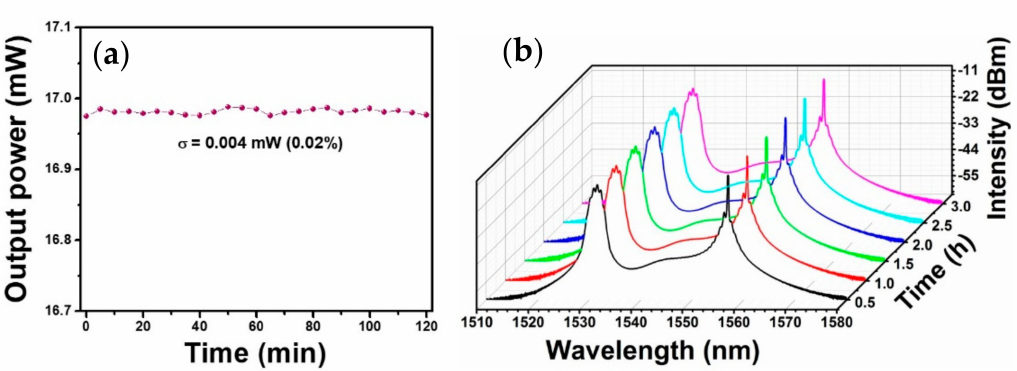
Figure 9. Long-term stability of ( a ) output power with the standard deviation of 0.004 mW and ( b ) output spectra at a pump power of 500